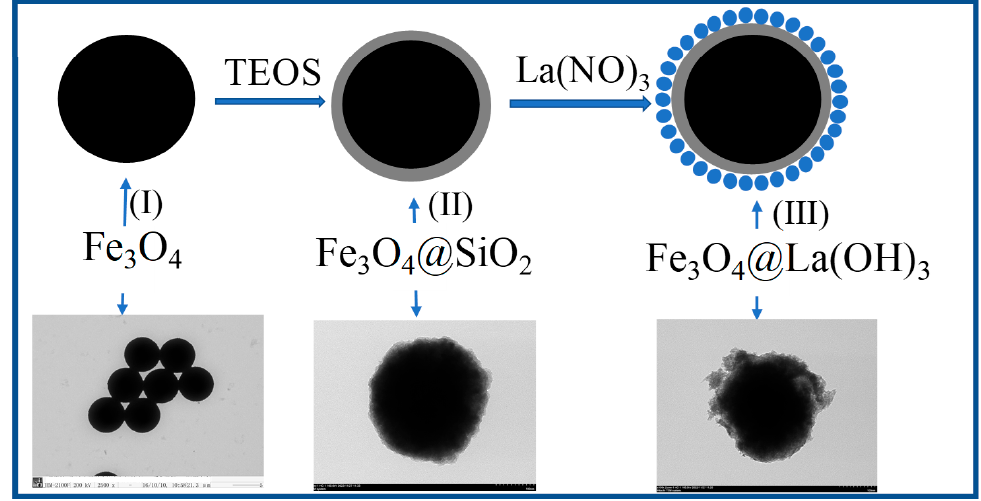
Figure 1. Schematic illustrations of the fabrication procedure for the Fe 3 O 4 @La(OH) 3